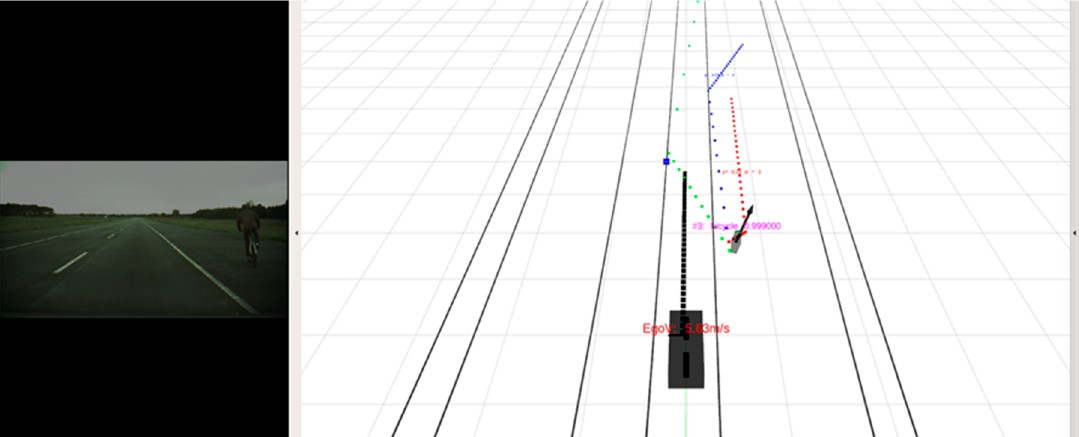
Figure 20. Two examples of tra ffi c scene prediction from the